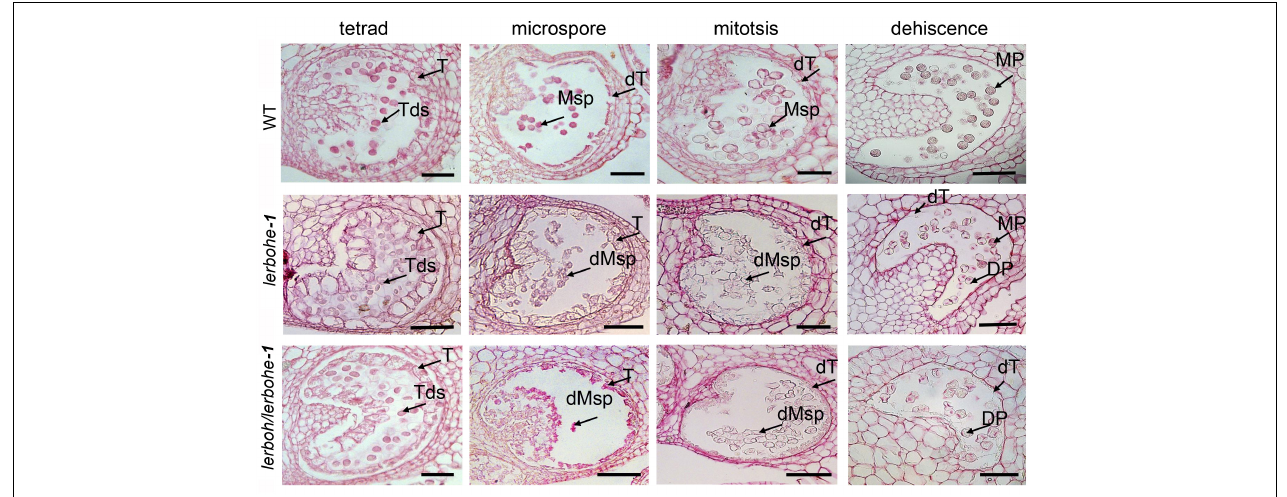
FIGURE 4 | Phenotypic analysis of the tapetum layer in AC, lerbohe or lerboh lerboh anthers via paraffin sectioning. T, tapetum; dT, degraded tapetum; Tds, tetrad; PMC, pollen mother cell; Msp, microspores; MP, mature pollen; DP, degraded pollen; dMsp, degraded microspores. Scale bar: 100 µ m.